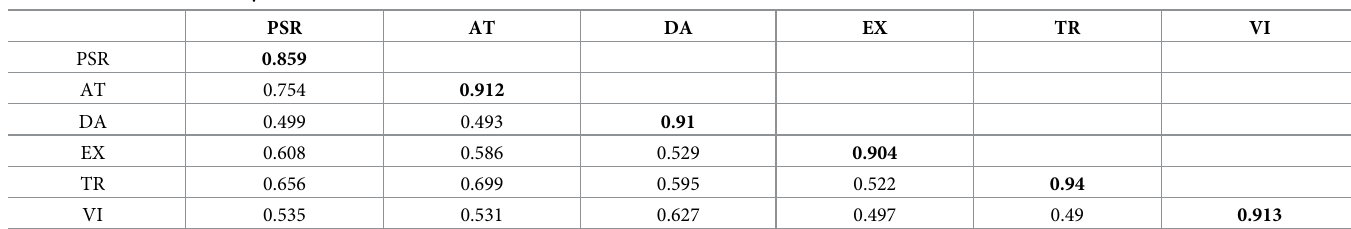
Table 3. Discriminant validity.